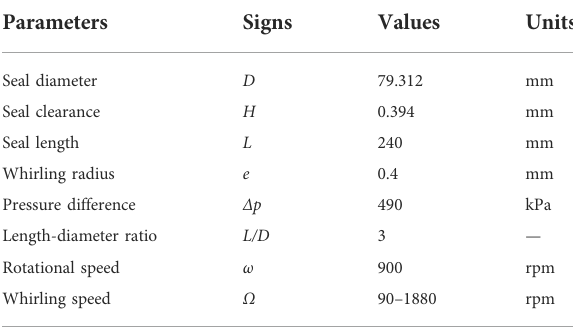
TABLE 1 The geometrical dimensions and operating conditions of the seal (Kanemori and Iwatsubo, 1994).